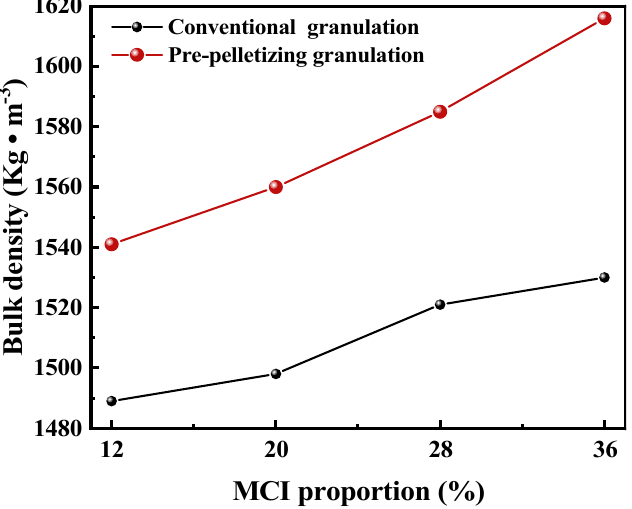
Figure 8. Quasi-particles bulk density from conventional and pre-pelletizing granulation.